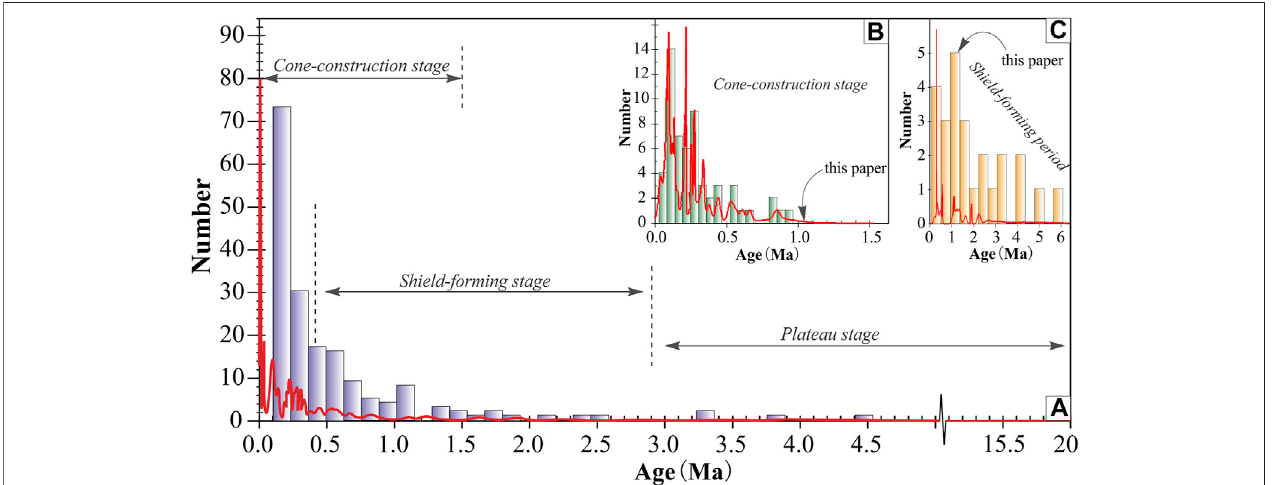
FIGURE9|(A) AsummaryofagesofthelateCenozoicvolcanicrocksintheChangbaiMountainvolcanicareaandadjacentareas(e.g.,Fanetal.,1999;Nakamura et al.,2000); (B) agefrequencydiagramofvolcanicrocksduringtheconeconstructionstage intheChangbaishan Mountainsvolcanicarea(e.g.,Liu,1981,2015;Wang et al., 1999, 2001); (C) age frequency diagram of volcanic rocks during the shield-forming stage (other data sources are as for Figure 7 ).